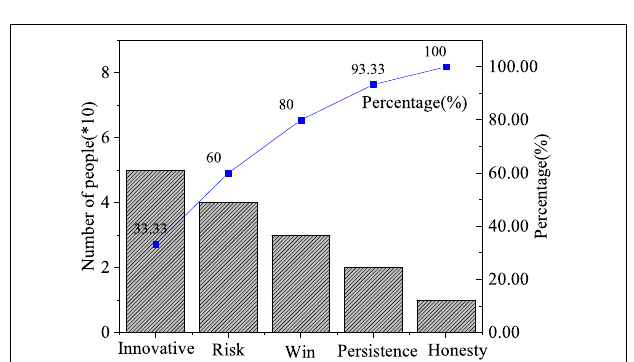
FIGURE 6 | Importance of entrepreneurial